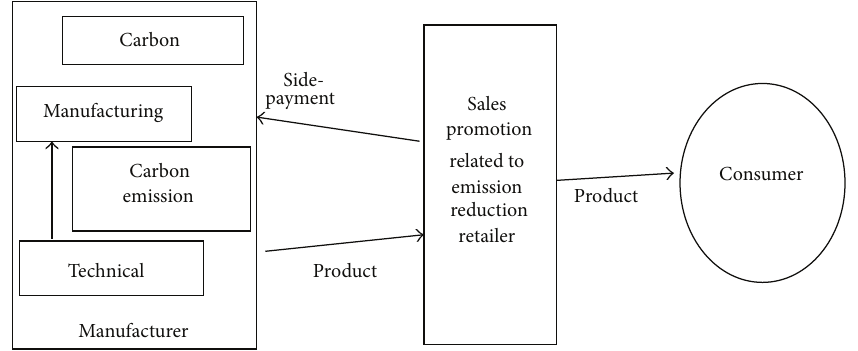
Figure 1: Manufacturer’s emission reduction, retailer- promoting cooperation, and